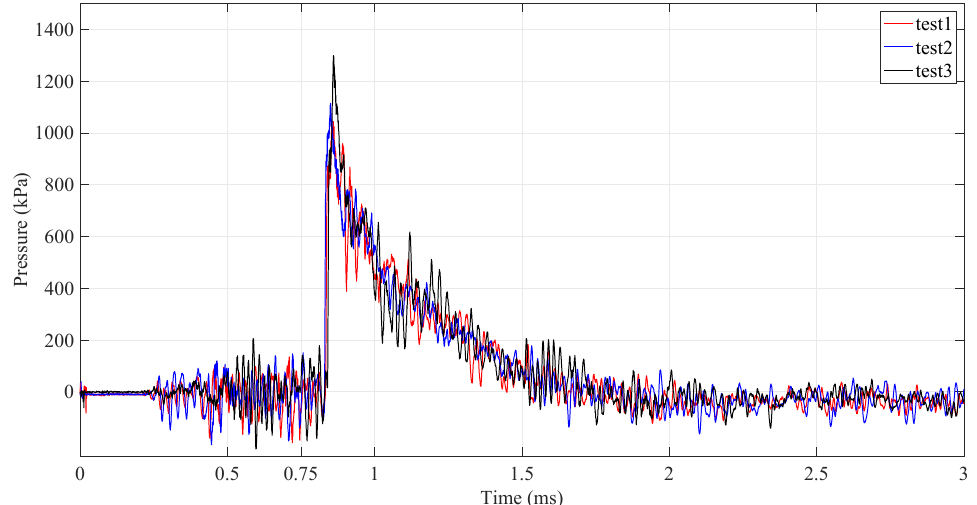
Figure 15. Pressure profile recorded by the high-frequency pressure sensor for the explosion of a 10 g C4 charge mass at the entrance of the